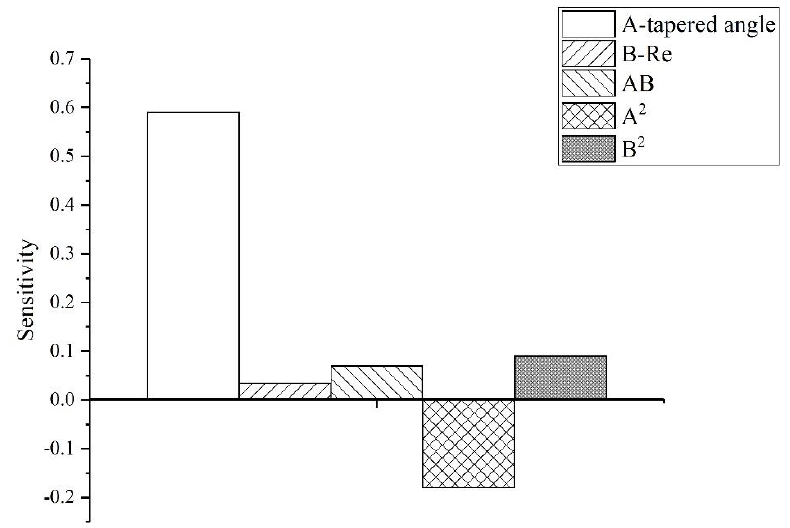
Figure 17. Sensitivity factor analysis results.